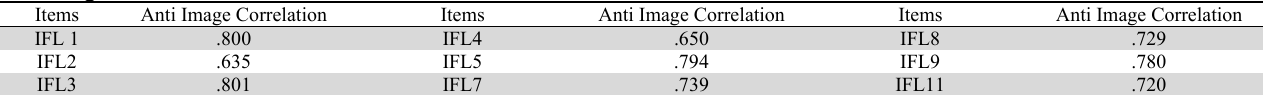
Anti Image Correlation